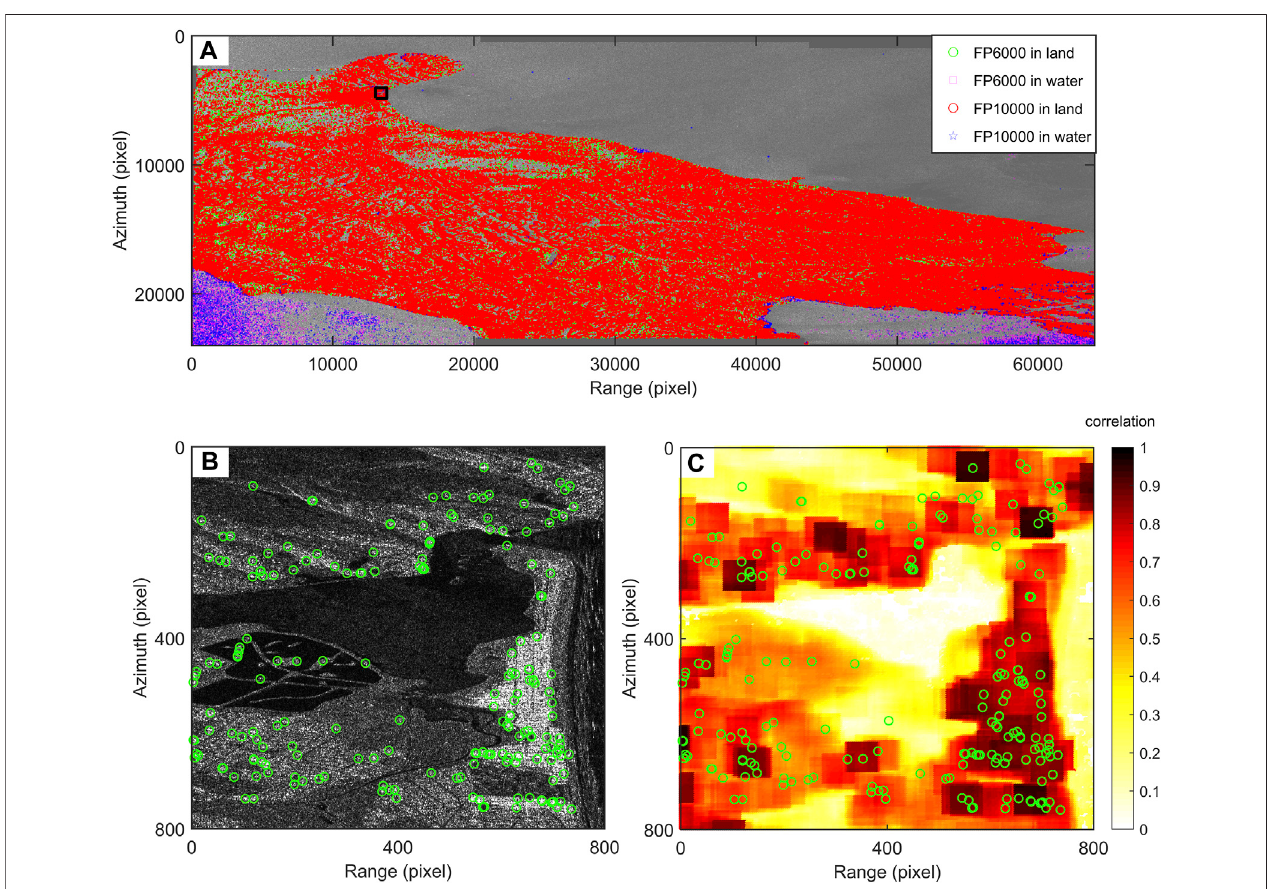
FIGURE 4 | Distribution of feature points and cross-correlation degrees. (A) The green circles and the magenta squares represent feature points on land and in water,respectively,obtainedbysettingtheHessianthresholdas6000.TheredcirclesandthebluestarsarethecorrespondingfeaturepointswiththeHessianthreshold of10,000. (B) Zoominoftheareadenotedasablackboxintheupper-leftcornerin (A) .Featurepointsaredenotedasgreencircles. (C) Cross-correlationdegreesofthe amplitude image with a matching window size of 64 × 64 pixels and a step of 4 pixels. Pixels in water are not masked to show correlation comparison.